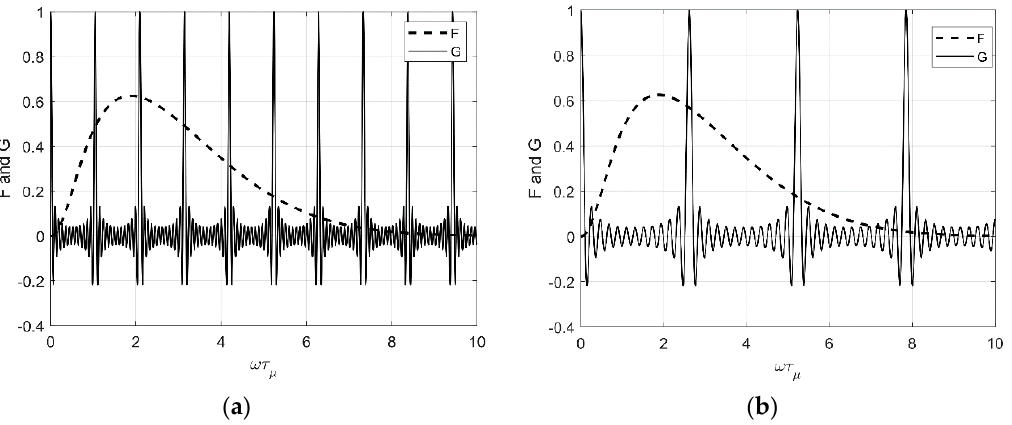
Figure 7. Power spectral response of optoacoustic pressure wave for ( a ) S = 0.5, N = 25, δ = 6 and ( b ) S = 0.5, N = 25, δ =